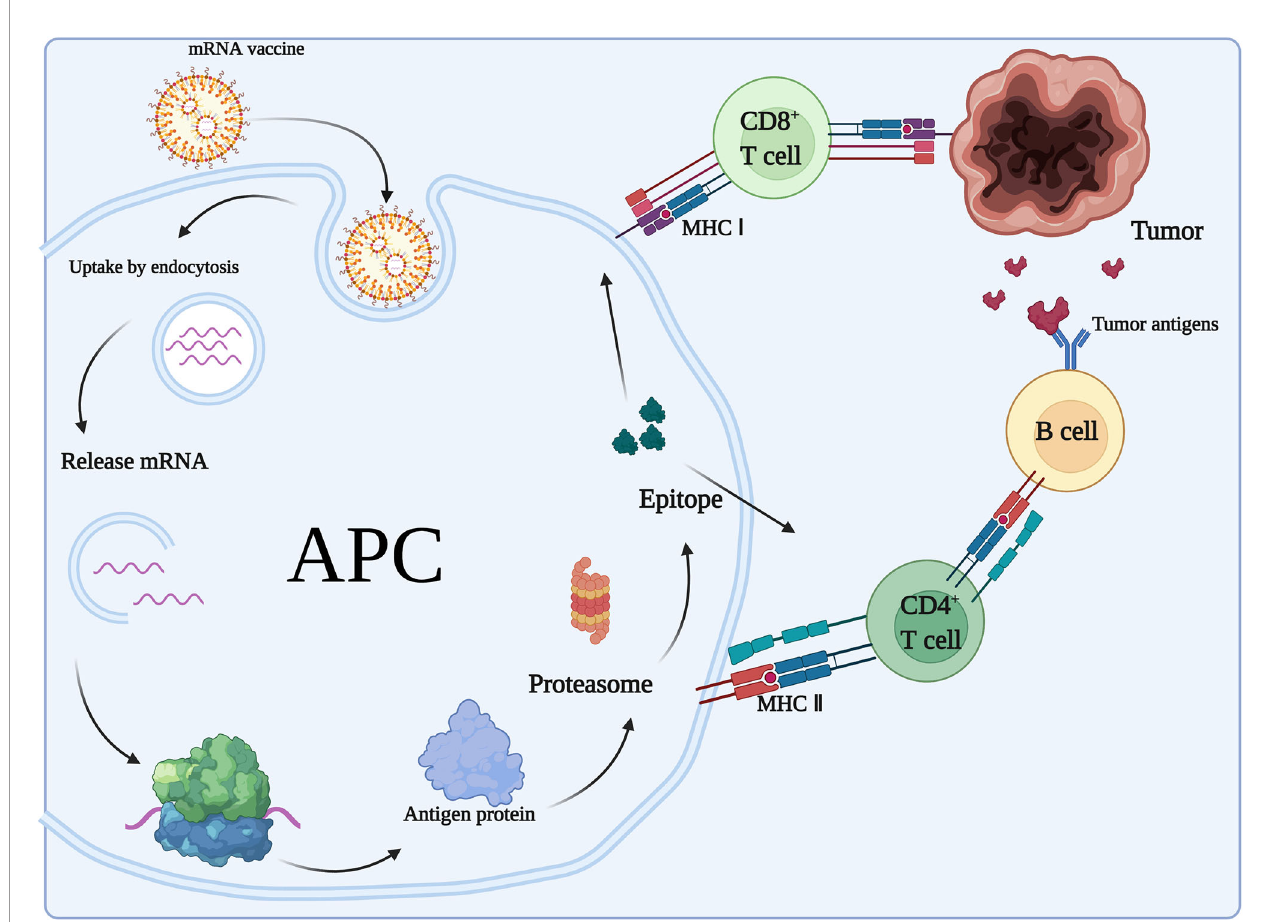
FIGURE 4 | Adaptive immune response to mRNA vaccines. In the case of mRNAs encoding antigens, mRNA vaccines exert immunological effects mainly through adaptive immune responses. After mRNA vaccination, the encoded proteins will be translated and taken up by APCs, which present the antigens to CD4+ T cells via MHC II and cross-present them to MHC I on CD8+ T cells. CD4+ T cells can enhance the antitumor effects of B